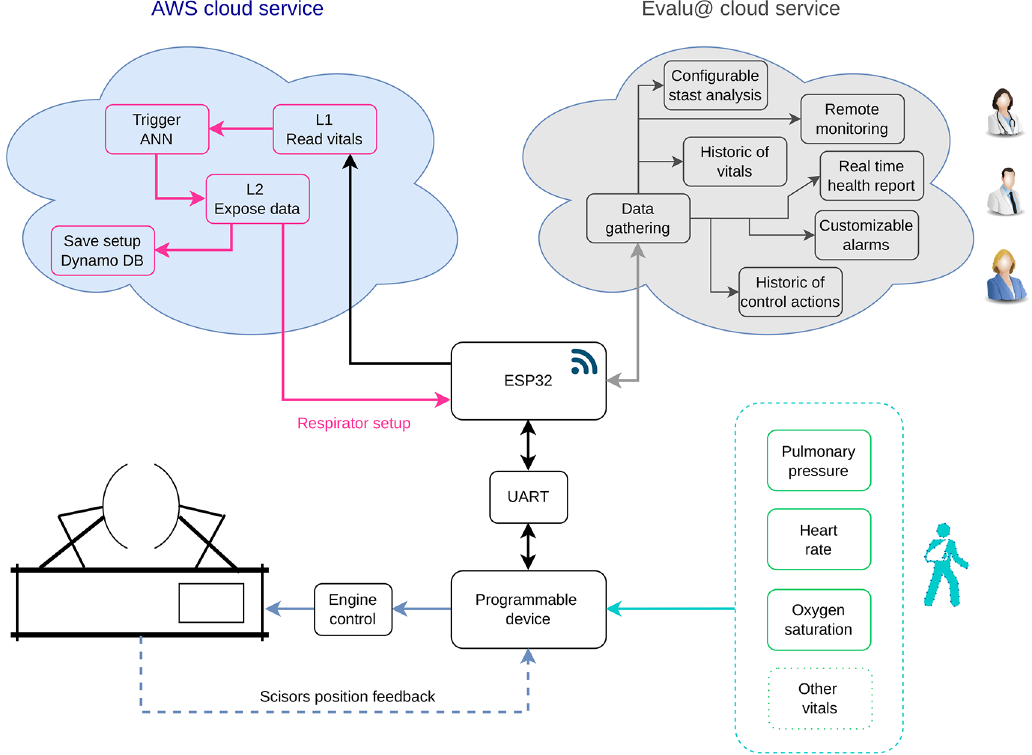
Figure 1. General diagram of the mechanical ventilator . The system has access to Amazon Web Service (AWS) for on-demand intelligent setup and Evalu@ for warning and reporting purposes to the side of the specialists and patient's relatives. ANN, UART, DB, and L# stand for artificial neuronal network, universal asynchronous receiver-transmitter, Database, and Lambda specification in AWS,